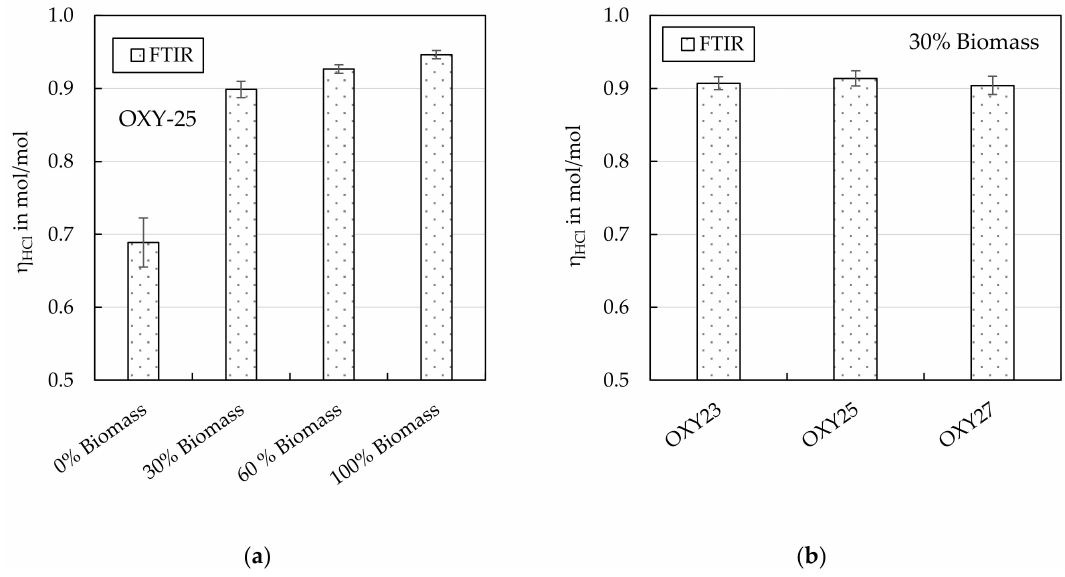
Figure 6. HCl retention rate ( η HCl ) as a function of the biomass share ratio ( a ) and the oxy-fuel case ( b